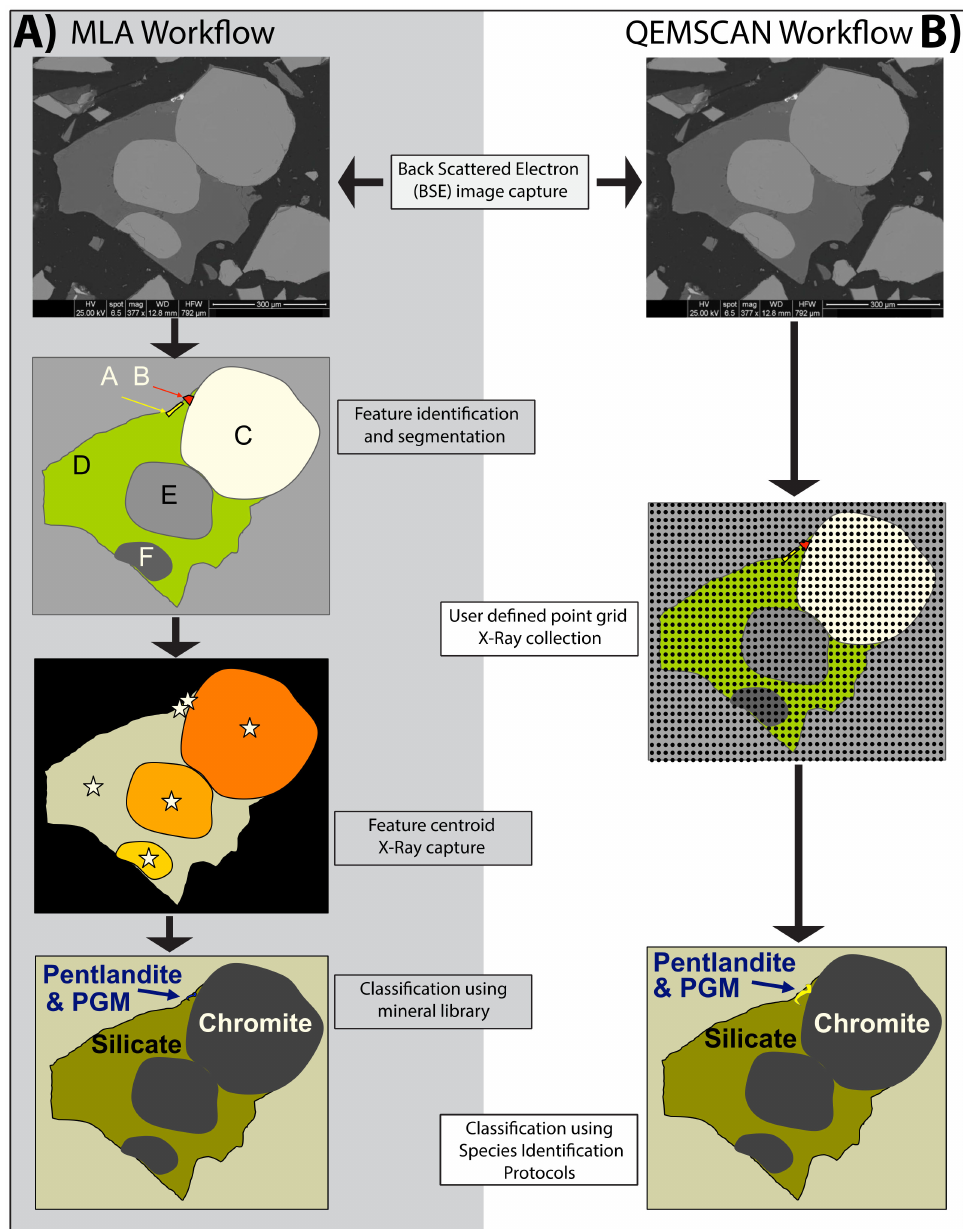
Figure 4. Example of sample workflow for automated mineralogy for ( A ) m ineral liberation analysis (MLA) and ( B ) QEMSCAN™. Modified from Layton-Matthews et al., 2014